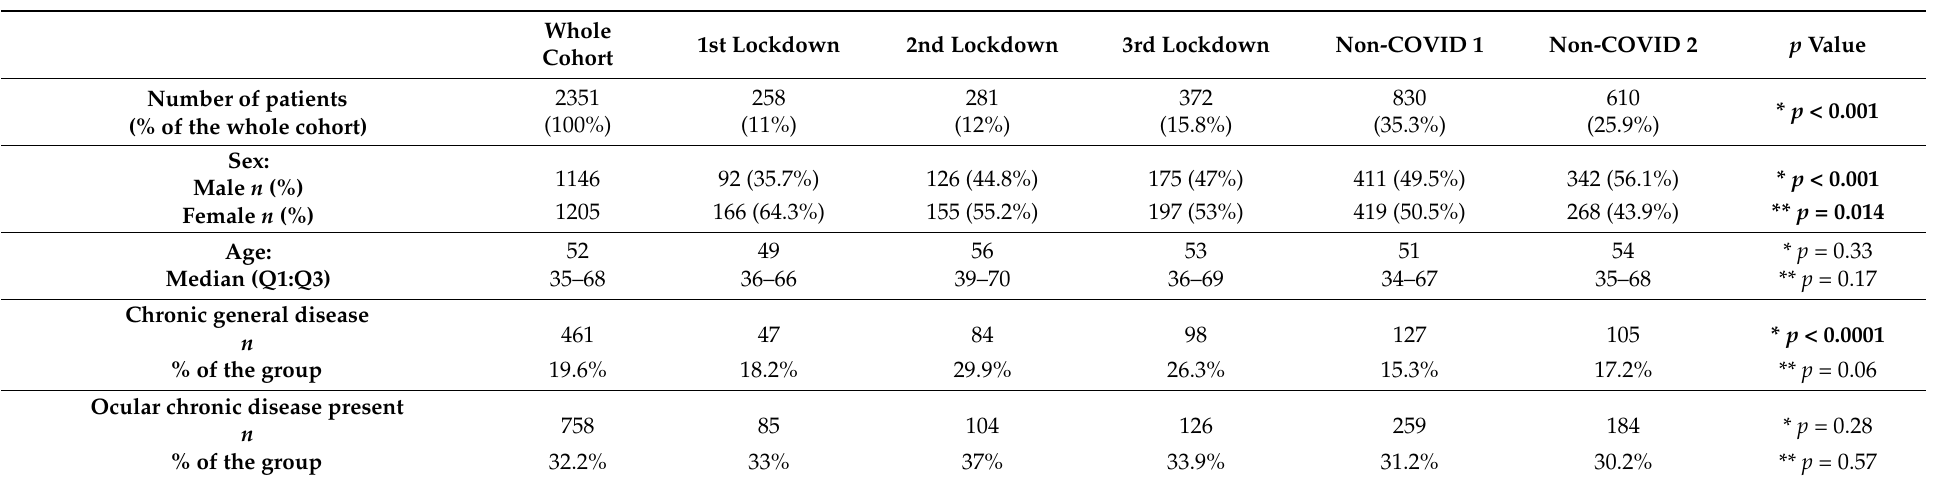
Table 1. Socio-demographic characteristics of patients admitted to the Emergency Department, Ophthalmology Unit, the Medical University of Warsaw, Poland, in three COVID-19 national lockdowns: 1st lockdown = 16th of March to 15th of April 2020, 2nd lockdown = 1st to 30th November 2020, 3rd lockdown = 16th of